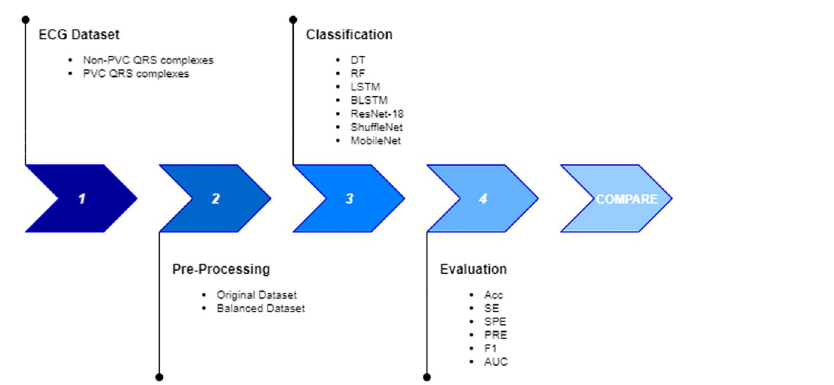
Fig 6. Bottleneck residual block of MobileNetv2 with stride =